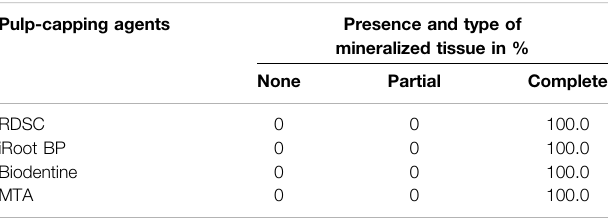
TABLE 2 | The continuity of mineralized tissue in 70-days in-vivo miniature pig model. No signi fi cant difference was detected among the pulp-capping agents investigated ( p >